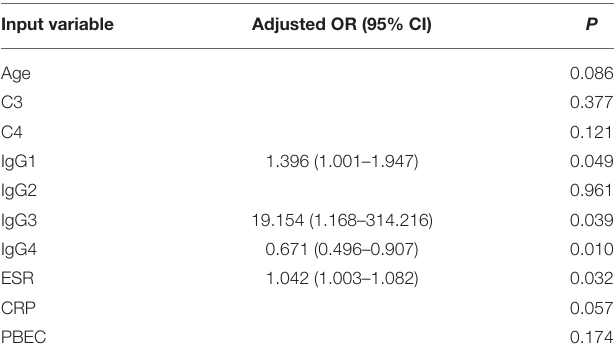
TABLE 5 | The adjusted odds ratio of variables for poor long-term outcome evaluated by eGFR ( < 45 ml/min per 1.73m 2 ) at 12